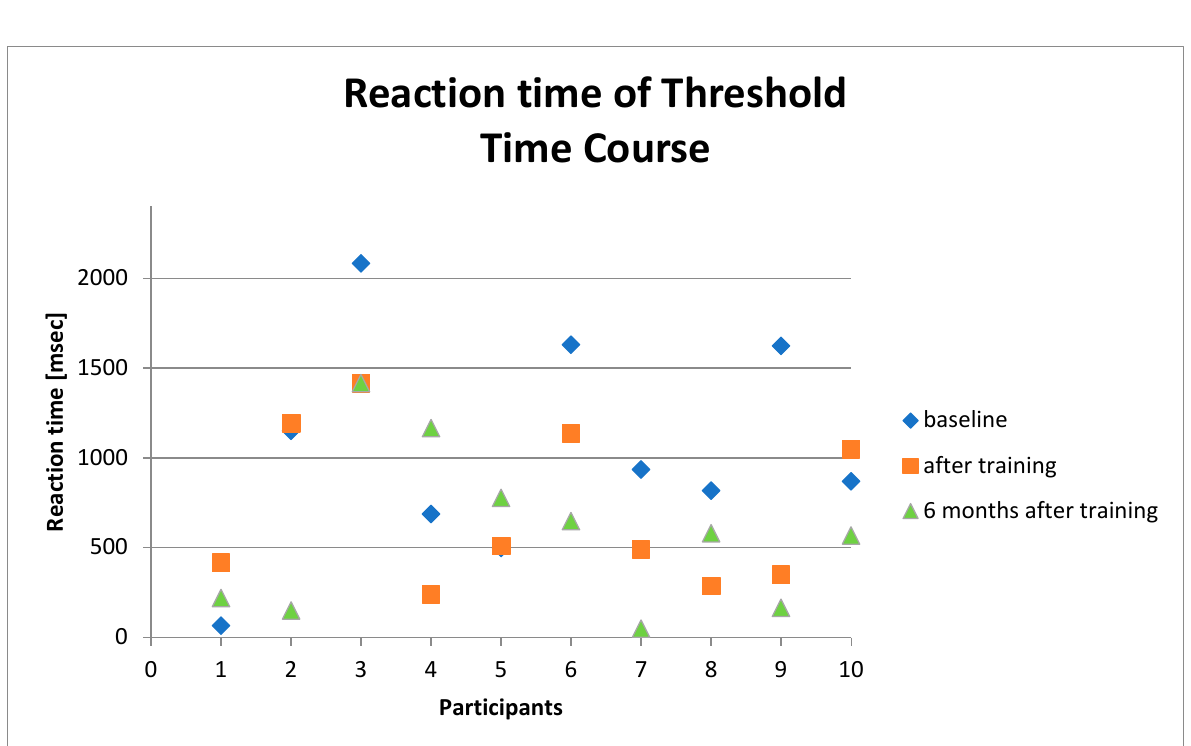
Figure 6. Individual time course of reaction time before training, after training, and after six months without training of 10 participants.